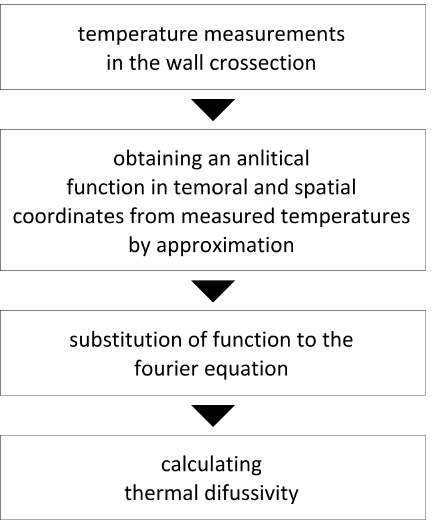
Figure 1. Method procedure.